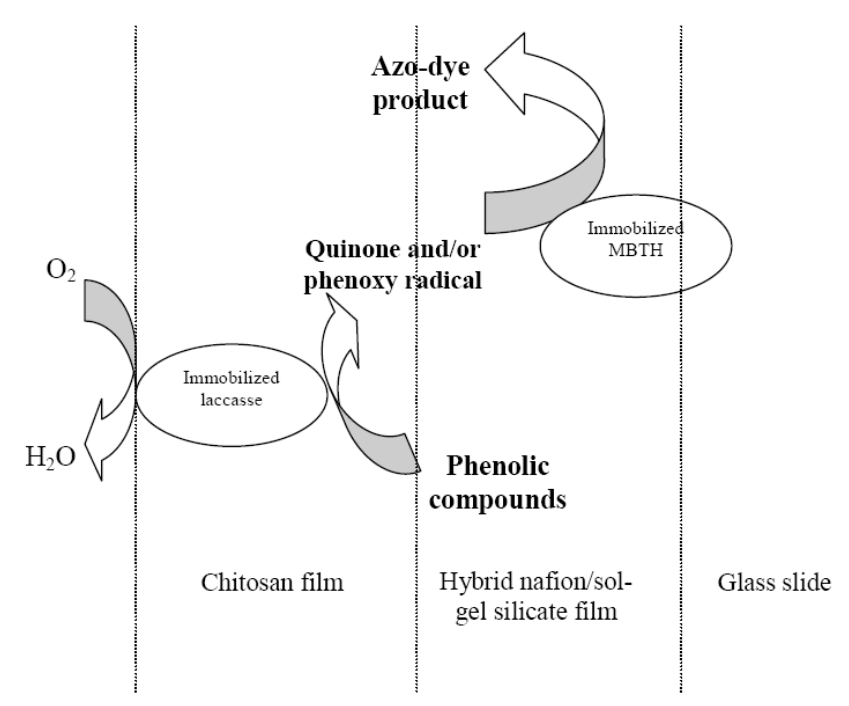
Figure 3 . Possible reaction mechanism between phenolic compound, immobilized laccase and immobilized